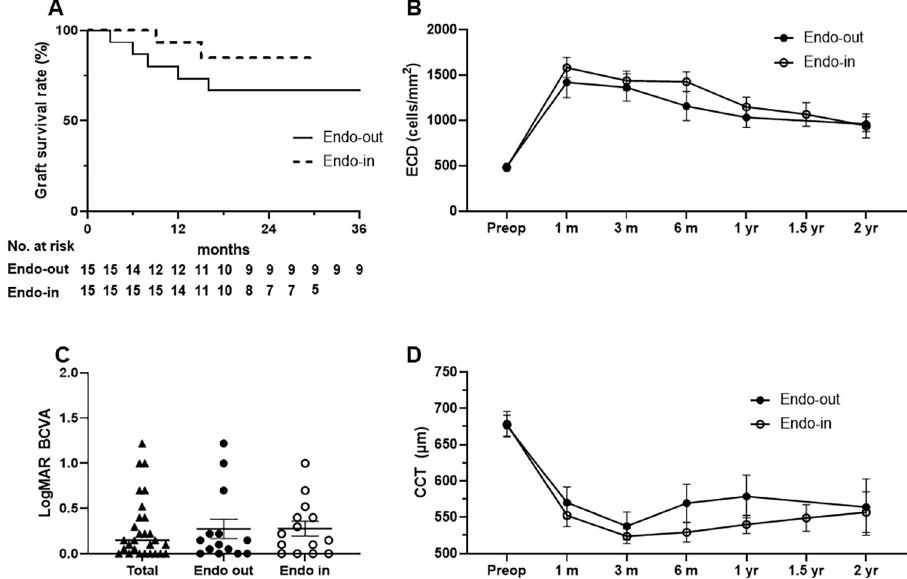
Fig 6. Comparison of the clinical outcome of descemet membrane endothelial keratoplasty (DMEK) between endothelium-out (endo-out) and endothelium-in (endo-in) groups. Kaplan-Meier plots of graft survival rate (A), endothelial cell density (ECD) (B), best corrected visual acuity (BCVA) (C), and central corneal thickness (CCT) (D). There were no differences between those two groups over time. Data are expressed as the mean ± standard error of the mean (B, C, D).